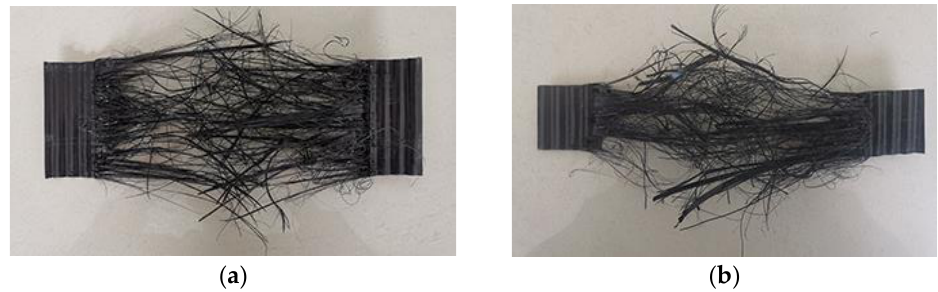
Figure 10. Fracture modes of the PP specimens. ( a ) Type I; ( b ) Type II.